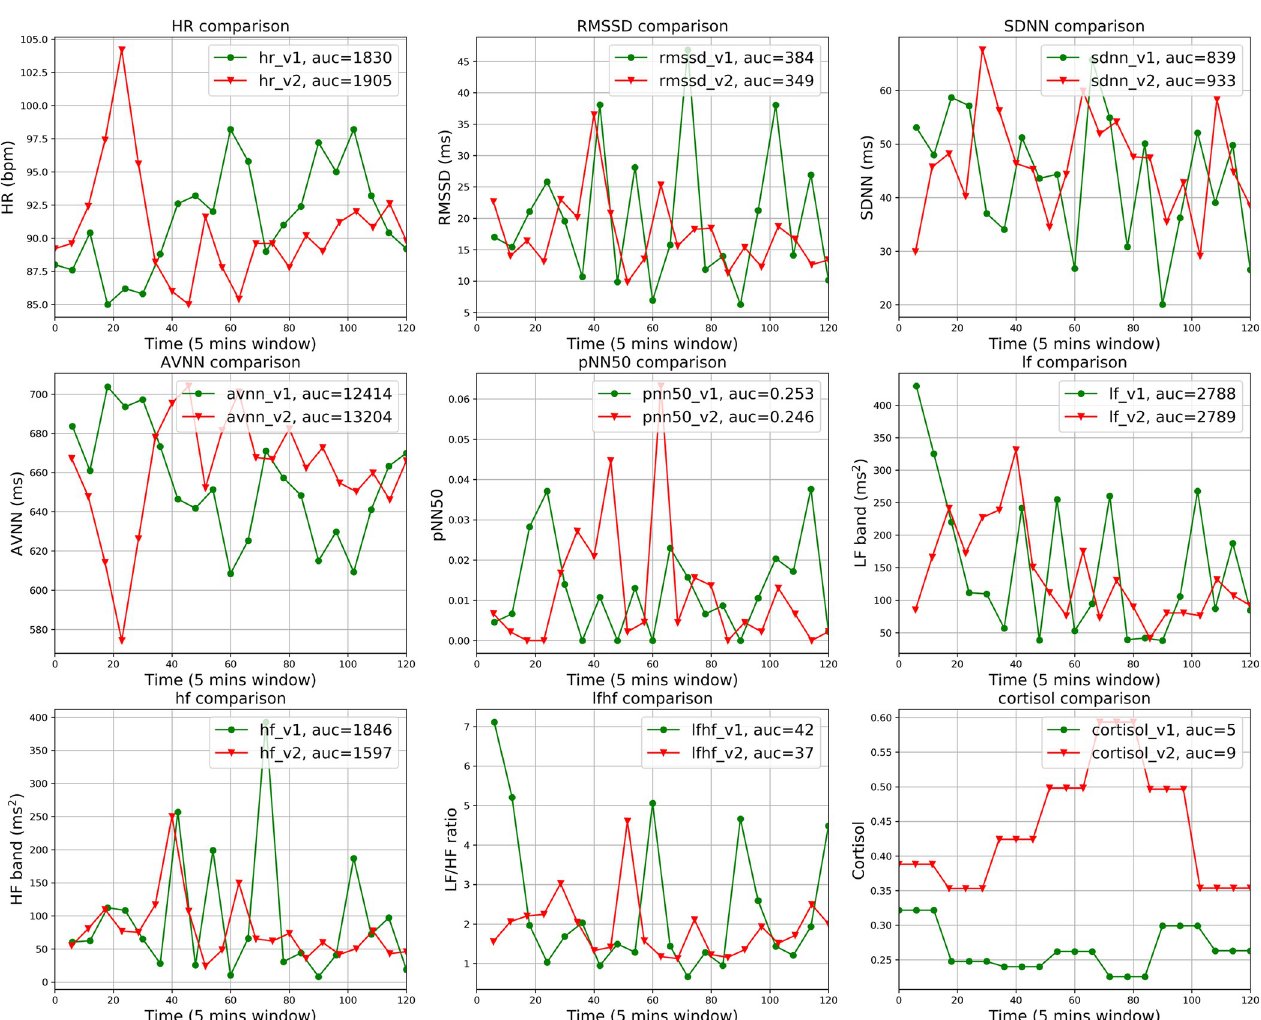
Fig 3. Comparison of the HR, HRV parameters, and cortisol between visit 1 and visit 2 in 5-minute segments for a sample participant. This participant did not demonstrate a clear difference in HR and HRV parameters but did have a significant difference in salivary cortisol.